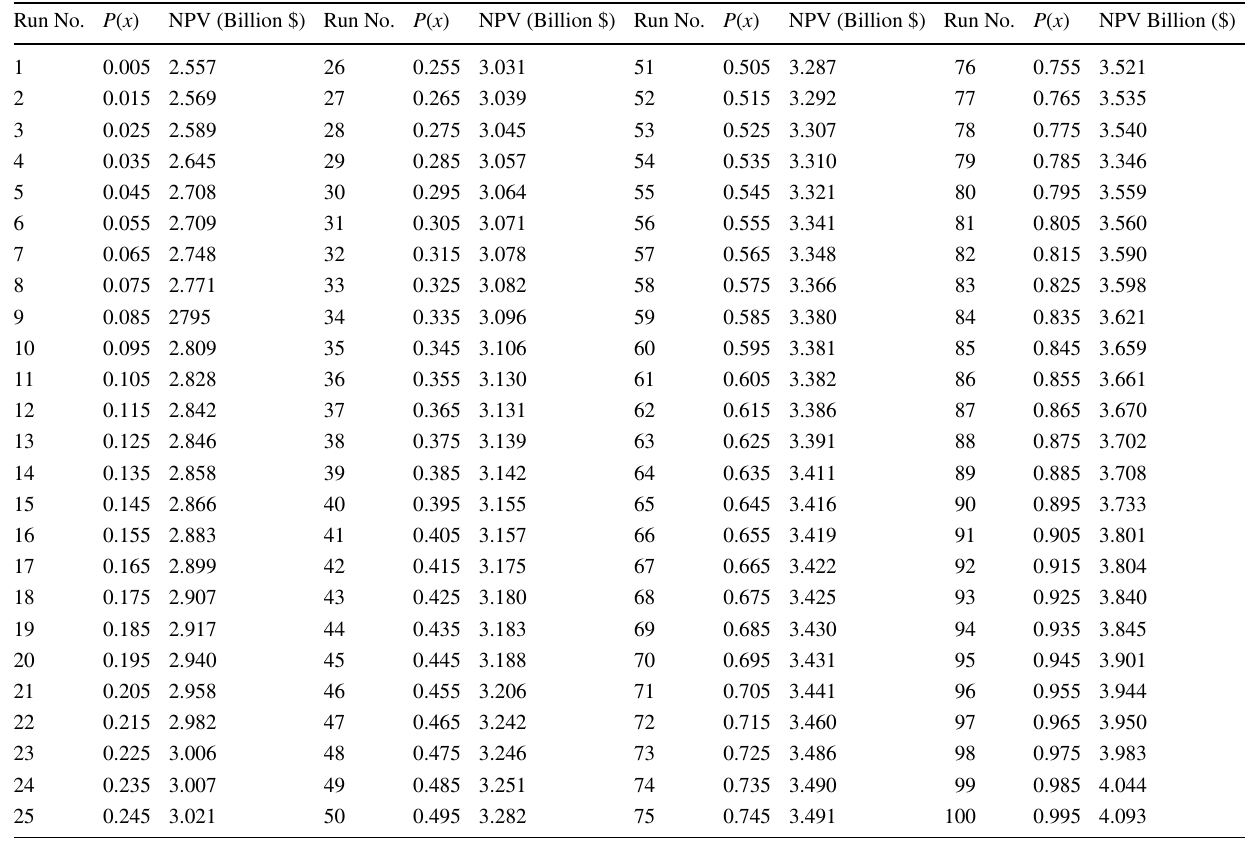
Table 6 NPV’s and associated probabilities for P10, P50 and P90 estimation Run No. P ( x )